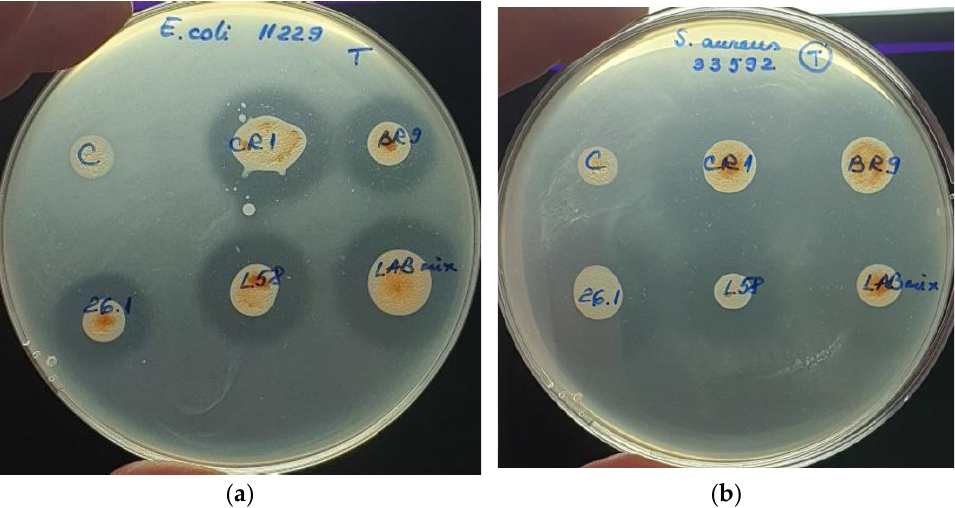
Figure 5. Antibacterial effect of fermented tomato juice: ( a ) E. coli ATCC 11229; ( b ) S. aureus ATCC 33592.